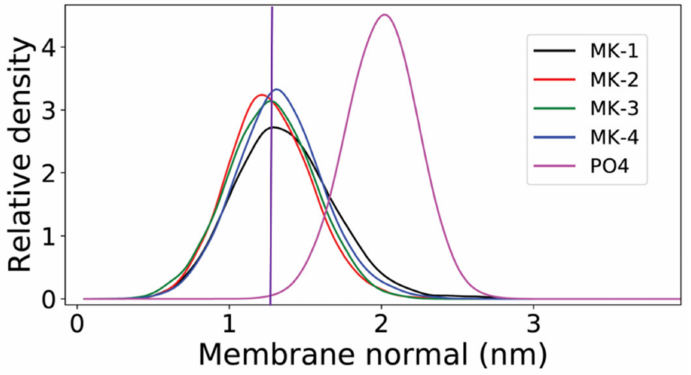
Figure 11. Relative mass density of the menaquinone headgroup along the membrane normal for MK-1 (black), MK-2 (red), MK-3 (green), and MK-4 (blue). The phosphate group of POPC (PO 4 ) is shown in magenta. The normal zero corresponds to the center of the bilayer. This figure was originally published in Ref. [1] and is licensed under CC-BY 4.0. The original figure was modified to include the purple, vertical